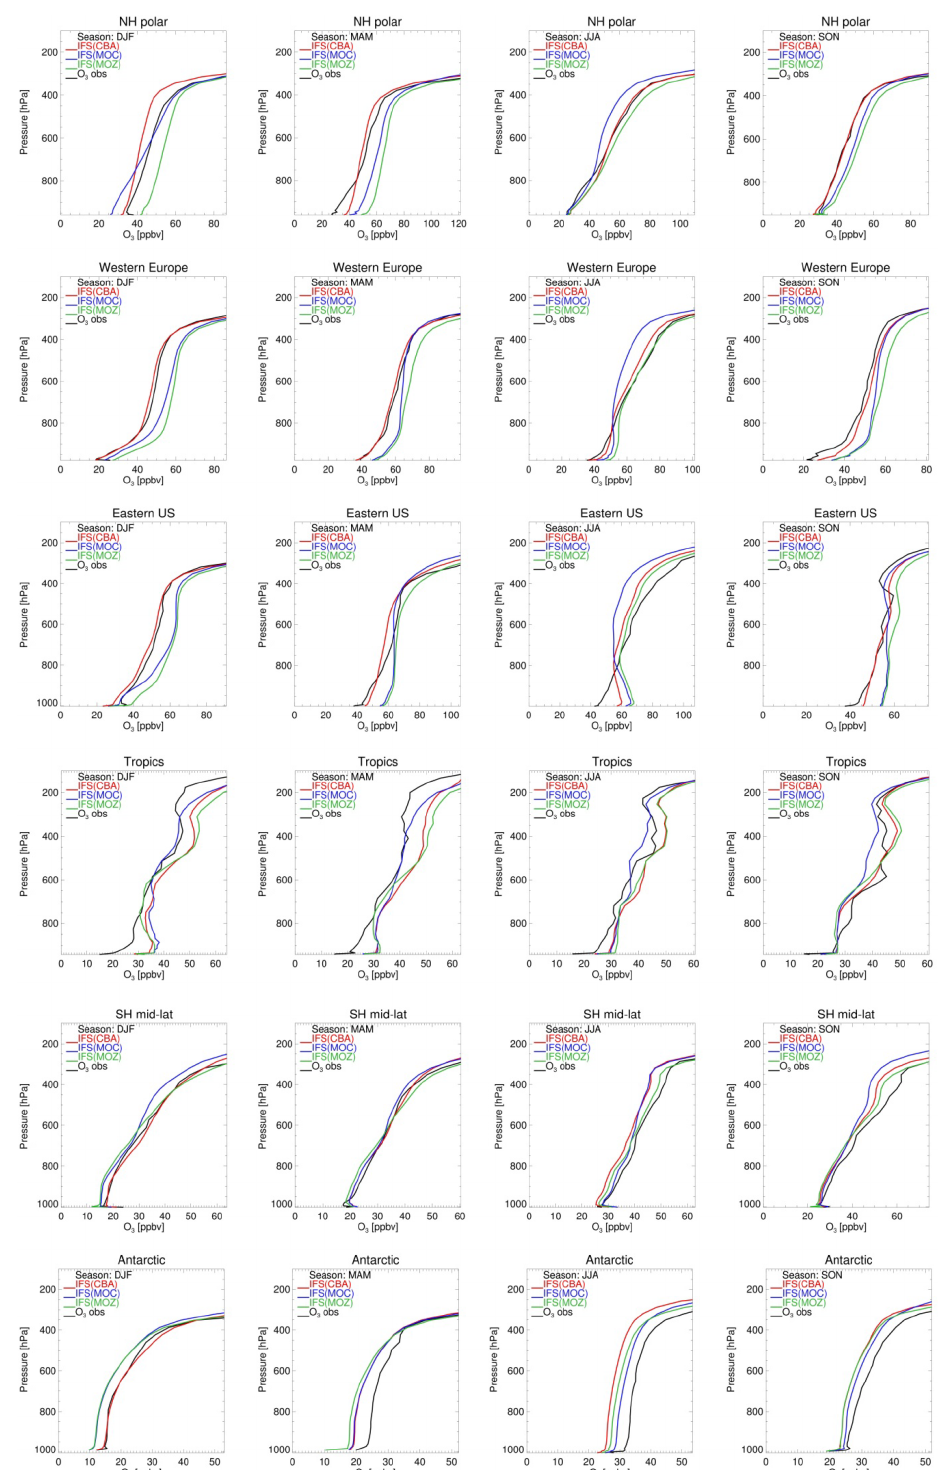
Figure 5. Tropospheric ozone profiles from model versions CBA (red), MOC (blue) and MOZ (green) against sondes (black) in volume mixing ratios (ppbv) over six different regions (from top row to bottom row): NH polar (90–60 ◦ N), western Europe (45–54 ◦ N; 0–23 ◦ E), eastern US (32–45 ◦ N; 90–65 ◦ W), the tropics (30 ◦ N–30 ◦ S), SH mid-latitudes (30–60 ◦ S) and the Antarctic (60–90 ◦ S), averaged over four seasons (from left to right: December–January–February, March–April–May, June–July–August,